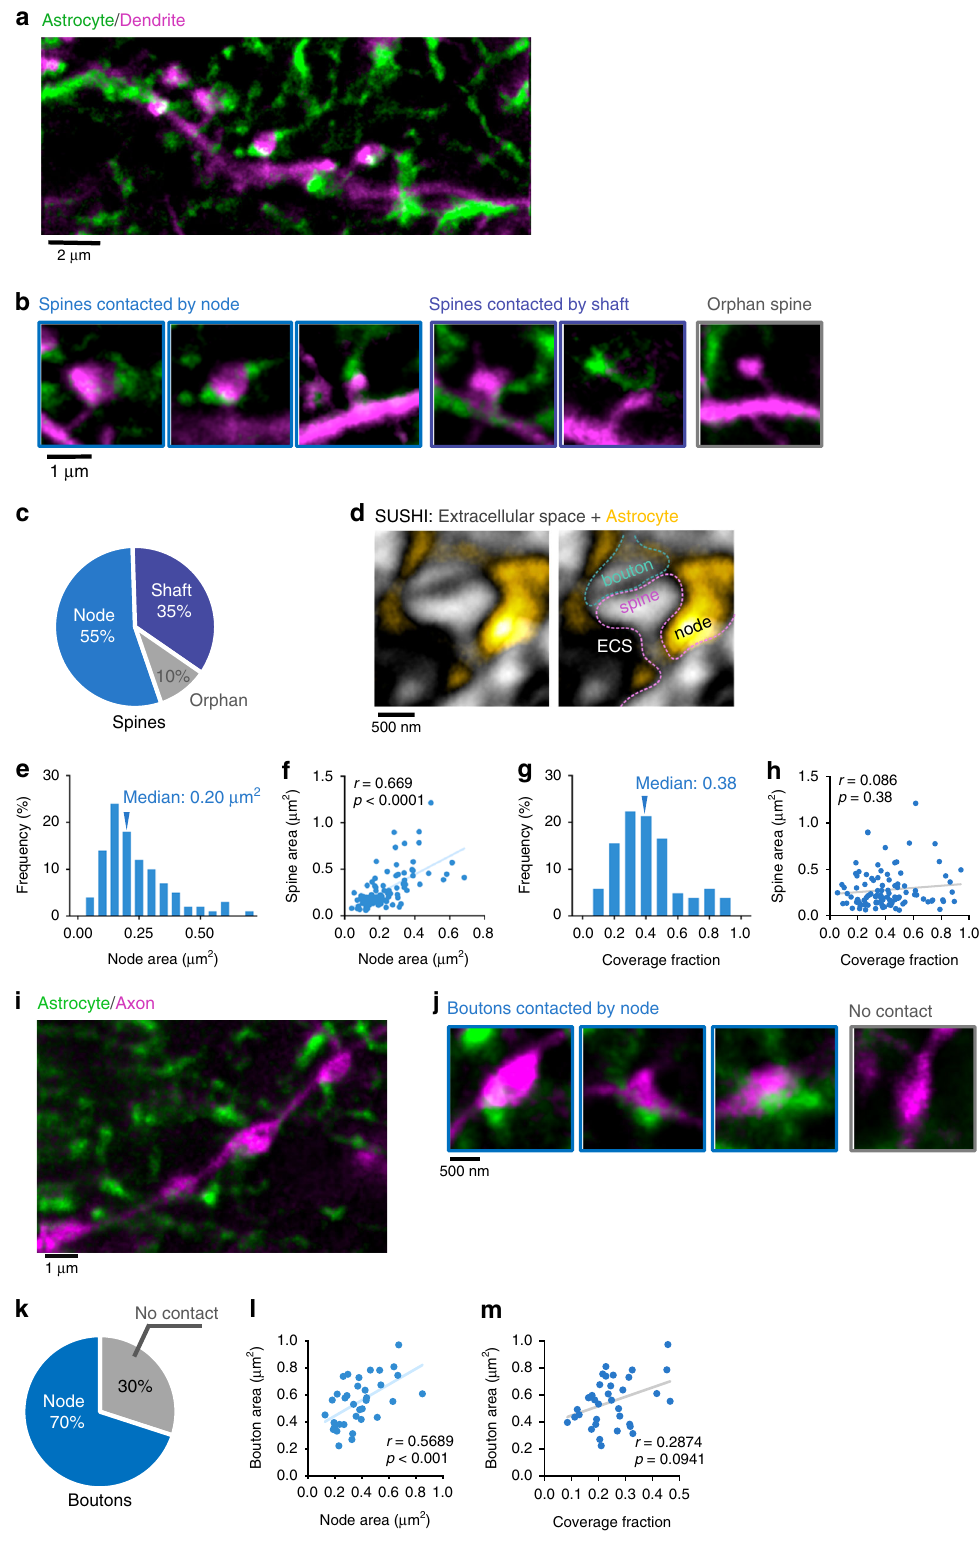
spine size did not correlate with coverage fraction, i.e. large spines had similar coverage fractions as small spines (Fig.